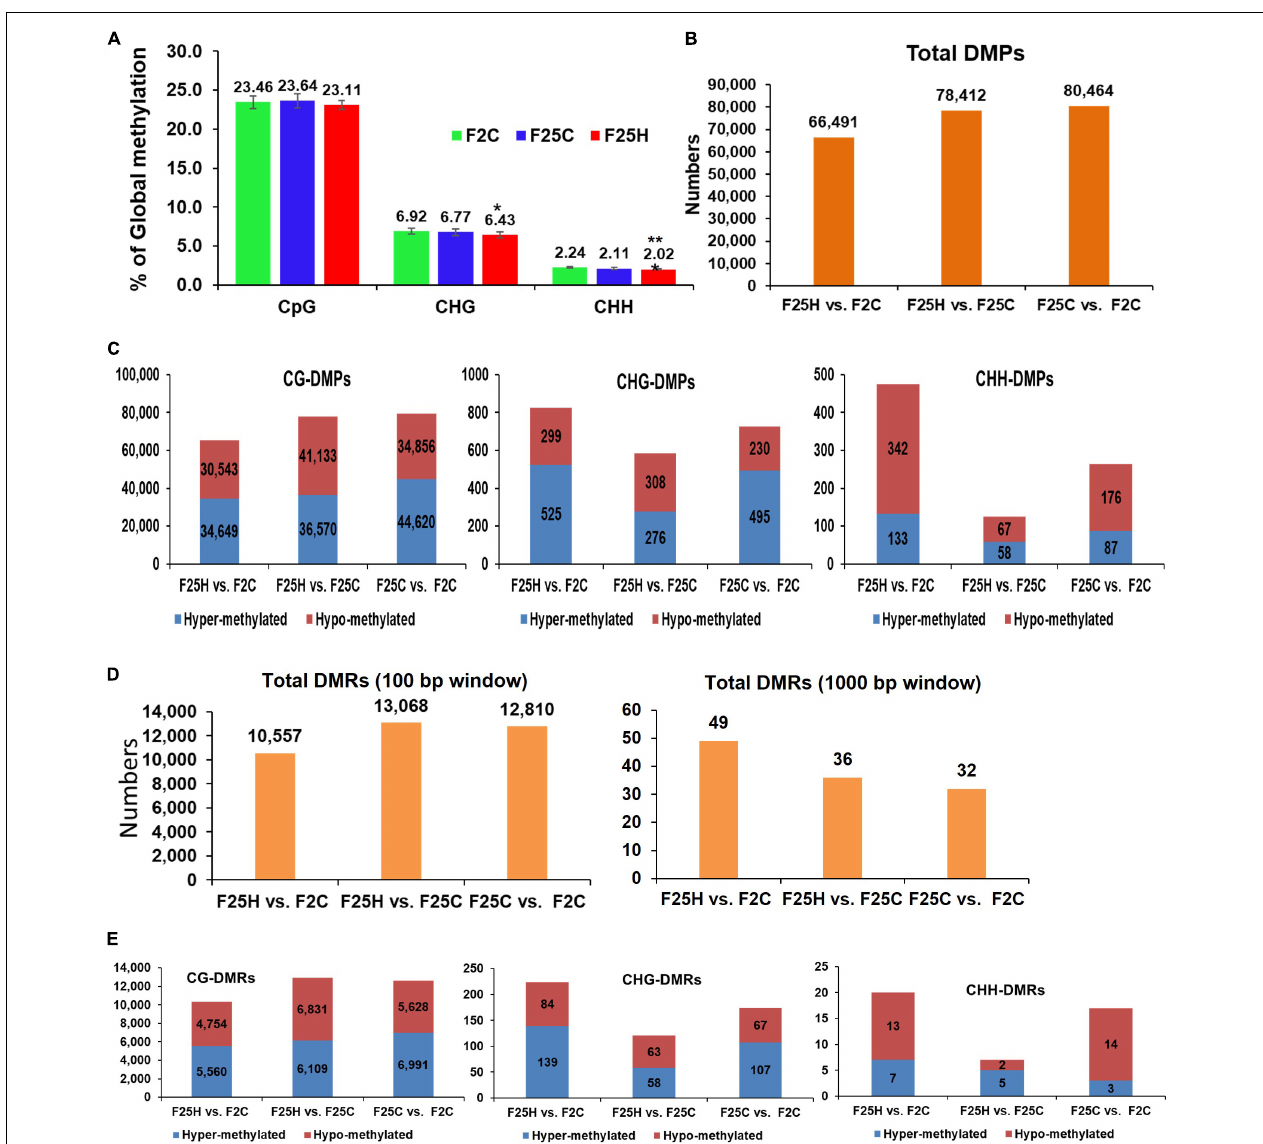
FIGURE 4 | Global methylation changes, differentially methylated positions (DMPs) and differentially methylated regions (DMRs) in F25H, F25C, and F2C plants. (A) The average percentage of methylated cytosines in F2C, F25C, and F25H in the CG, CHG, and CHH sequence contexts (H = A, T, C and mean, n = 5). Methylation levels were determined from reads with the minimum coverage ≥ 10 mapped to the TAIR 10 reference genome by using Bismark software. The data were analyzed by one-way ANOVA with the Tukey’s multiple comparisons test using GraphPad Prism version 8.4.2 for Windows. The data are shown as the average percentage (with ± SD) of methylated cytosines from five individual methylomes in each of the progenies. The asterisk shows a significant difference between the stressed progeny and the parental control progeny (* p < 0.1, **p < 0.05). (B) The total number of DMPs in F25H vs. F2C, F25H vs. F25C, and F25C vs. F2C. (C) The total number of DMPs in the CG, CHG, and CHH contexts in F25H vs. F2C, F25H vs. F25C, and F25C vs. F2C. (D) The total number of DMRs (100 and 1000 base pair window) in F25H vs. F2C, F25H vs. F25C, and F25C vs. F2C comparison groups. (E) The total number of DMRs (100 base pair window) in CG, CHG, and CHH contexts in F25H vs. F2C, F25H vs. F25C, and F25C vs.